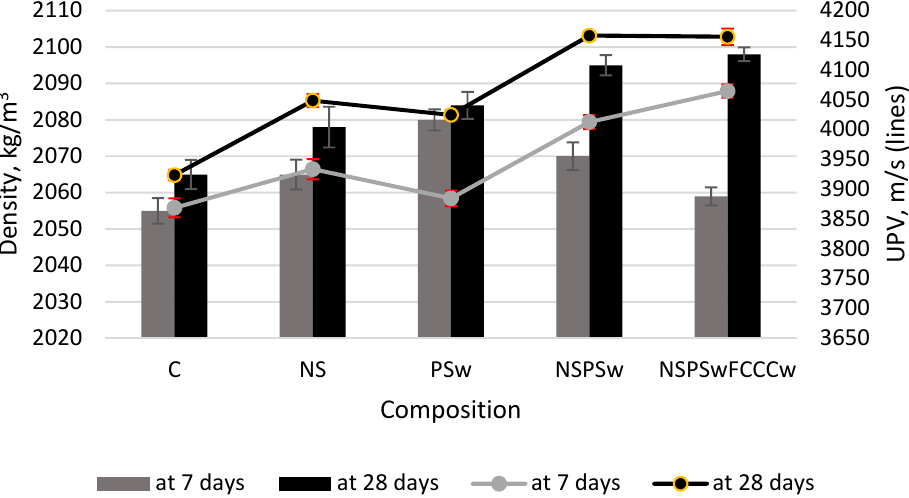
Figure 7. Density and ultrasonic pulse velocity (UPV) values of hardened cement paste at 7 and 28 days.